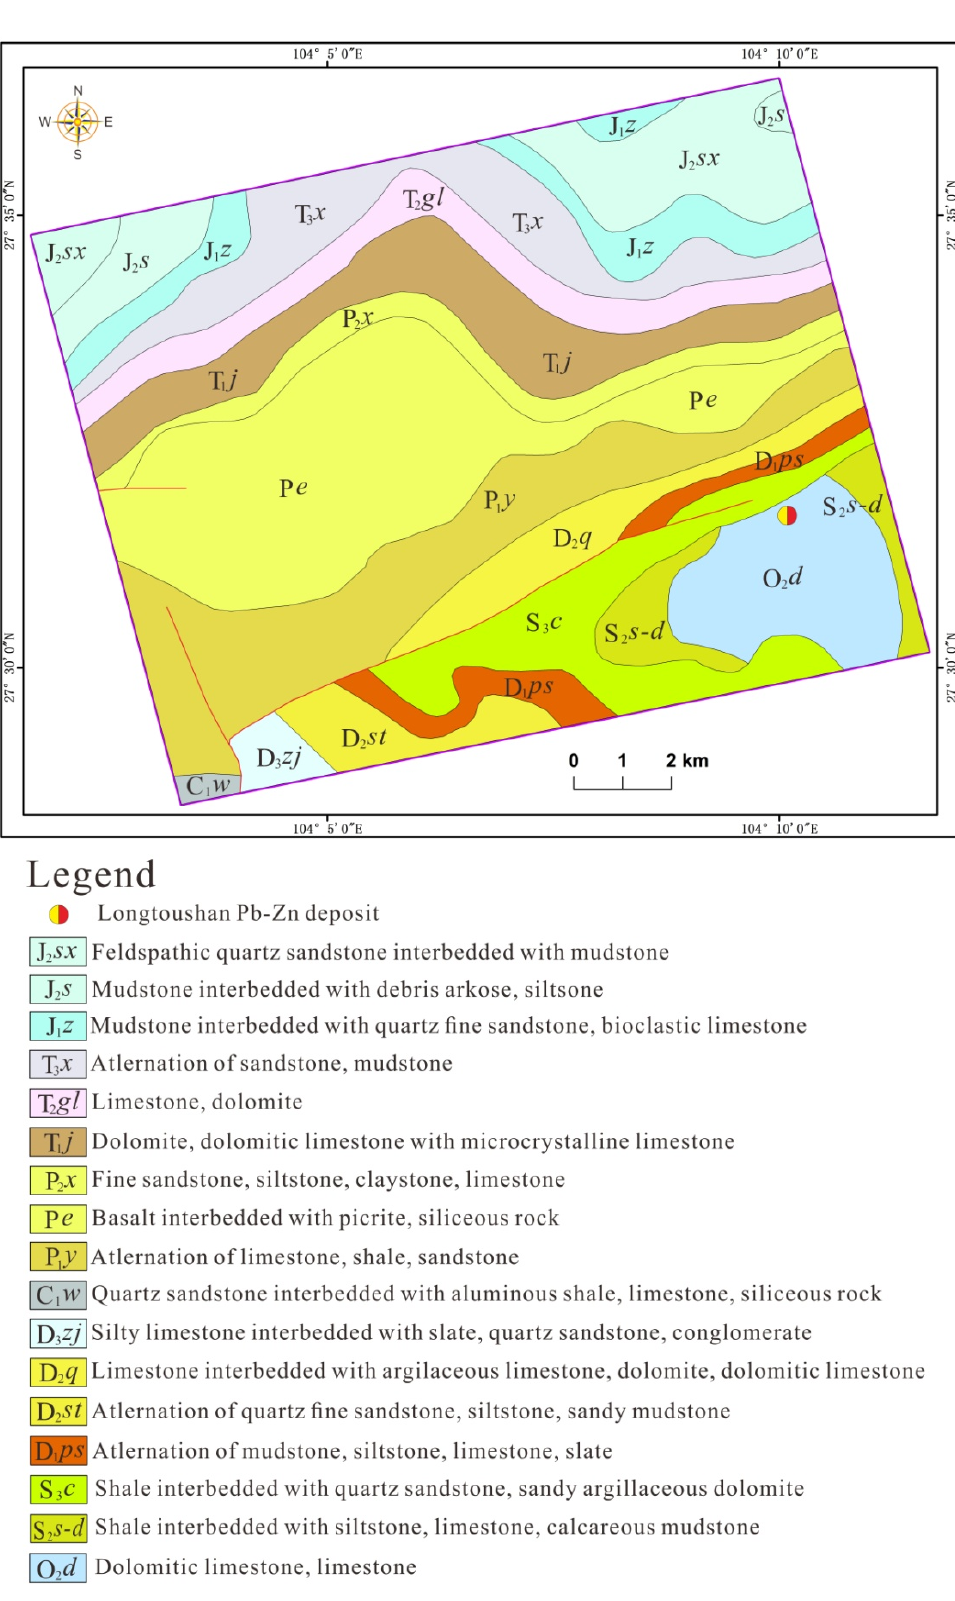
Figure 2. Geological map of the Longtoushan Pb-Zn deposit.